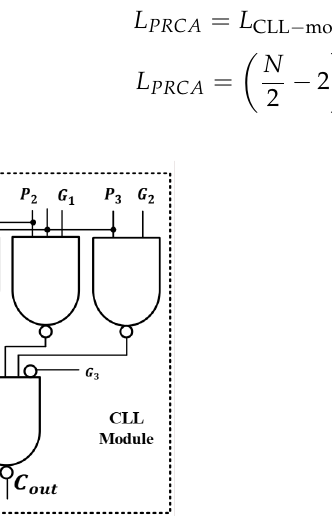
Figure 2. Logic diagram of a CLL